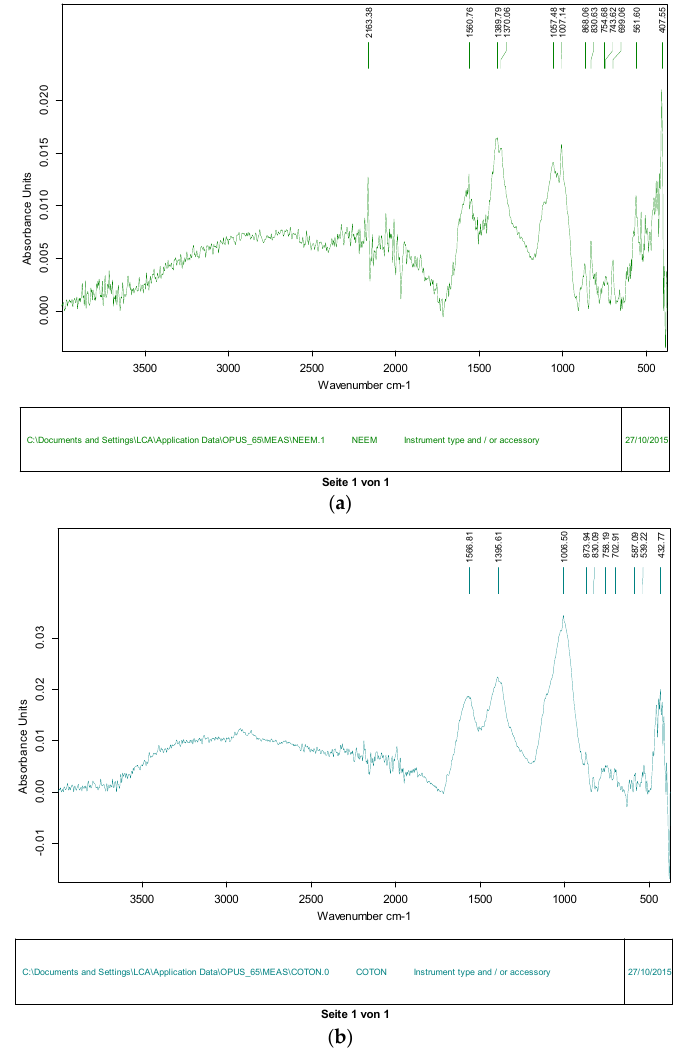
Figure 1. ( a ) FTIR spectra for AC from neem; ( b ) FTIR spectra for AC from cotton.